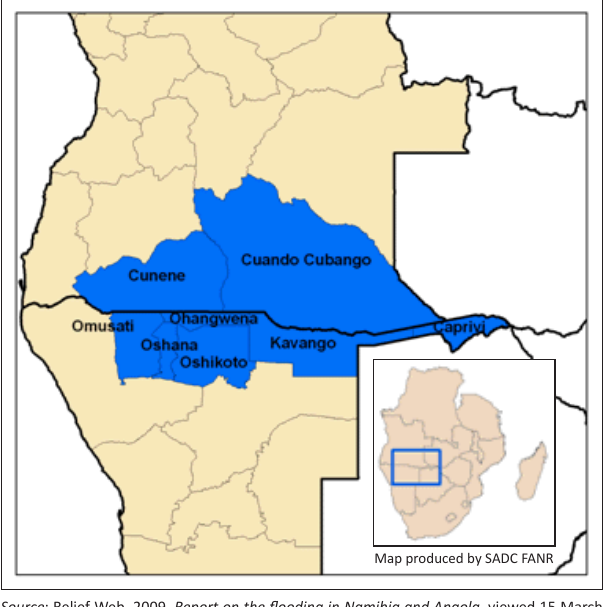
FIGURE 1: Geographical map of flood prone areas in Namibia.